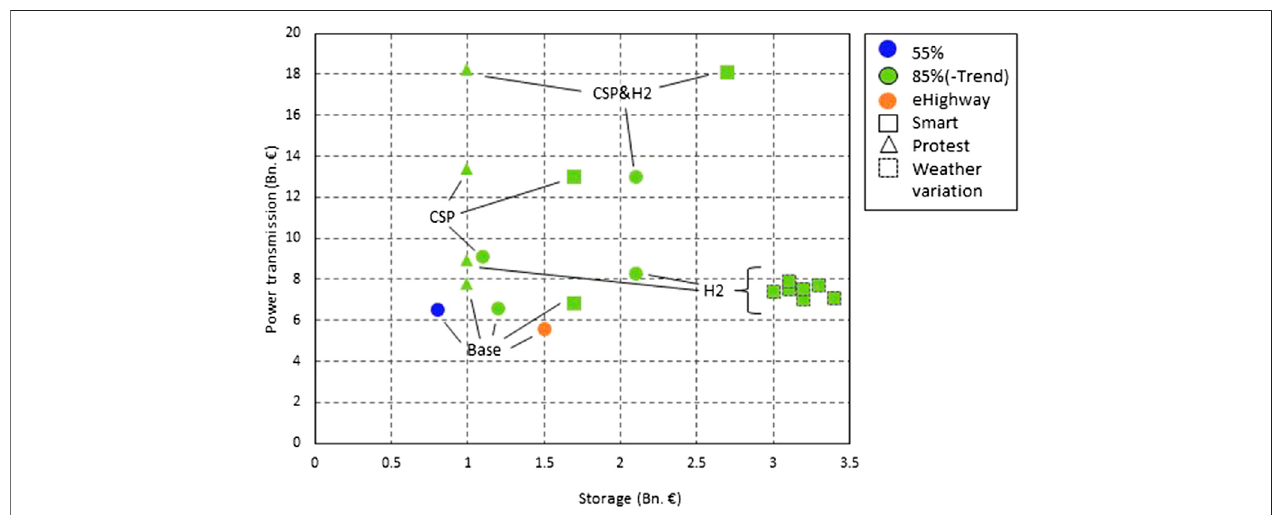
FIGURE 5 | Investments (annuities) required for expanding power transmission plotted vs. storage cost in Bn. € . Storage in CSP plants is neglected.